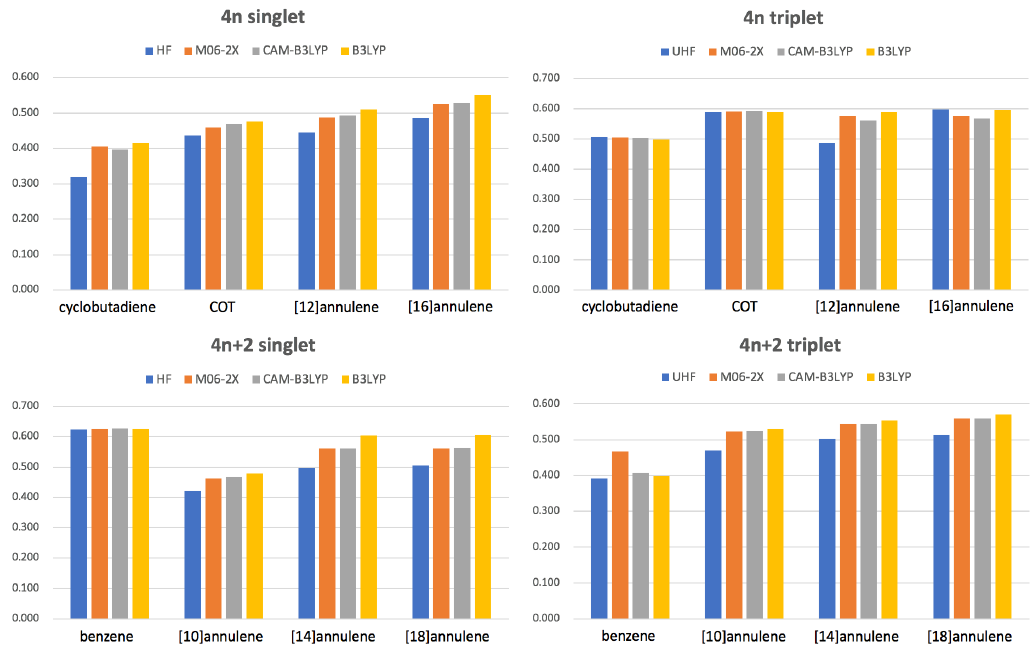
Figure 5. Values of I ring 1/ N for the lowest-lying states of the studied annulenes obtained with methods using a different percentage of Hartree Fock (HF) exchange: HF (100%), M06-2X (54%), CAM-B3LYP (19–65%) and B3LYP